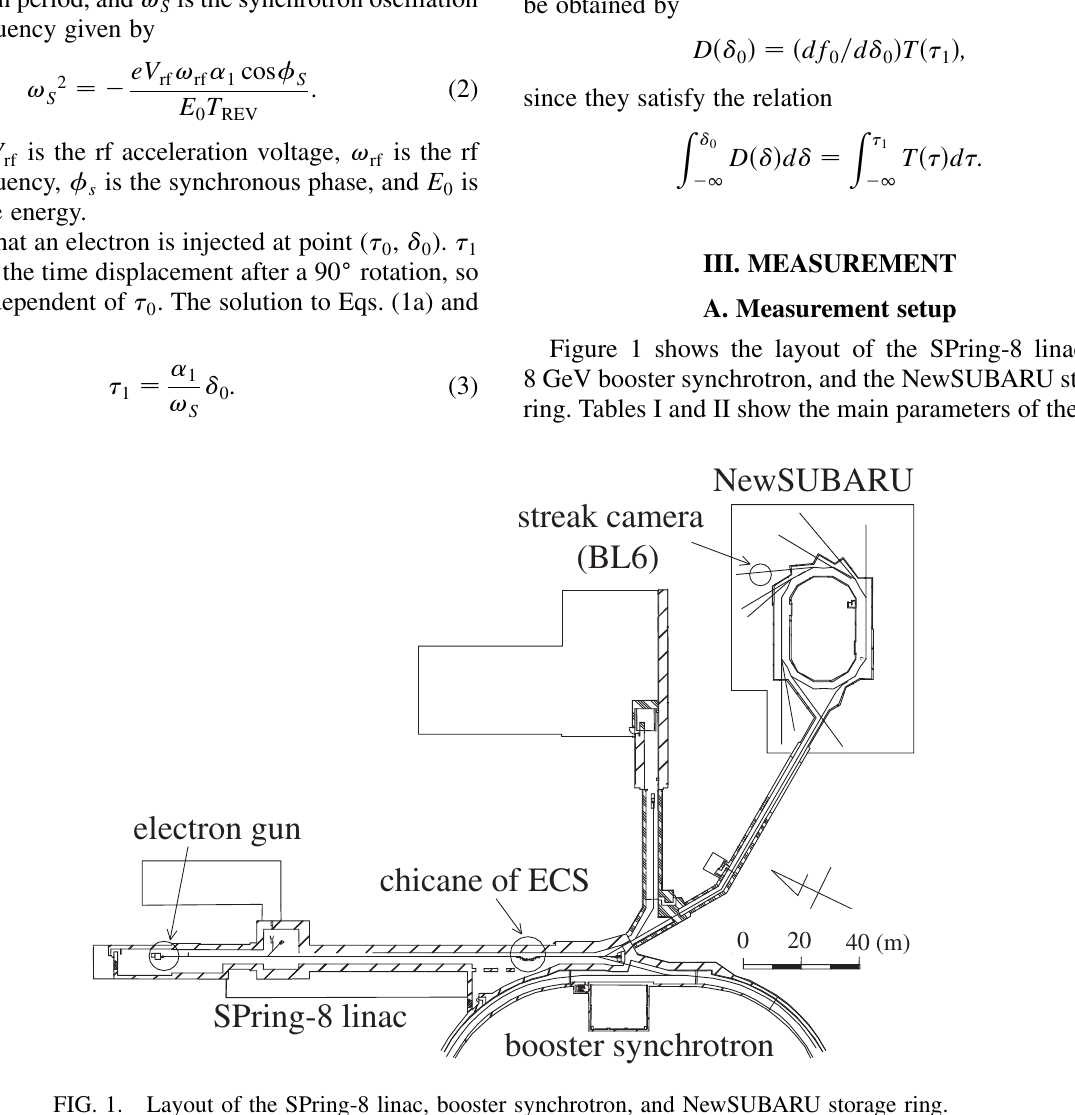
FIG. 1. Layout of the SPring-8 linac, booster synchrotron, and NewSUBARU storage